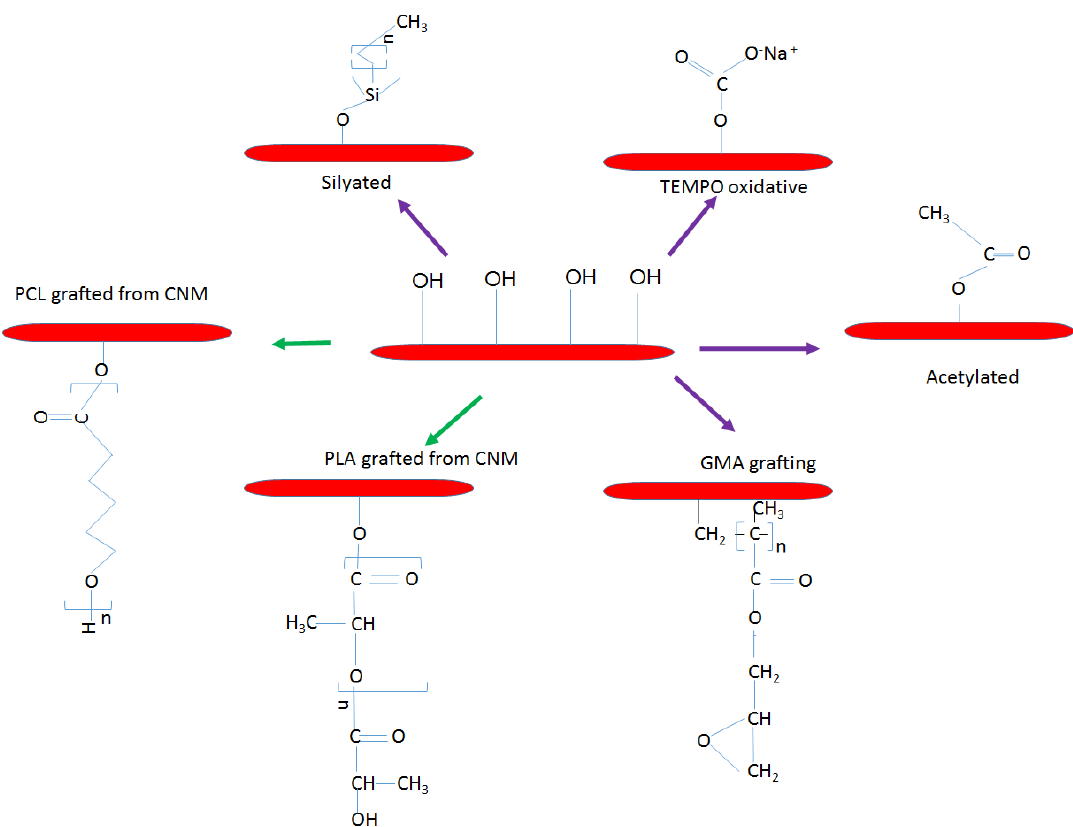
Figure 2. The commonly used chemical modification of CNM in PLA nanocomposites.